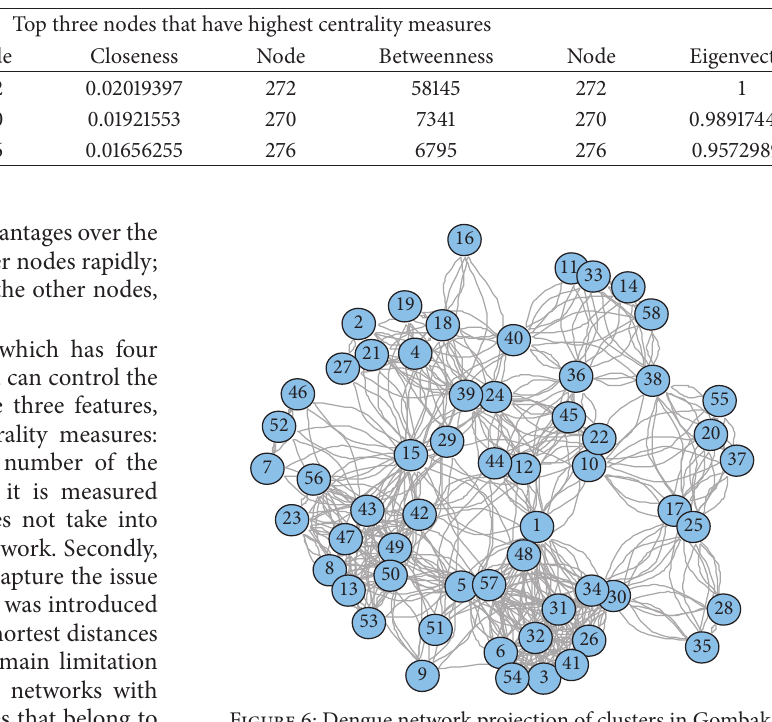
Table 6: Score of four centrality measures.